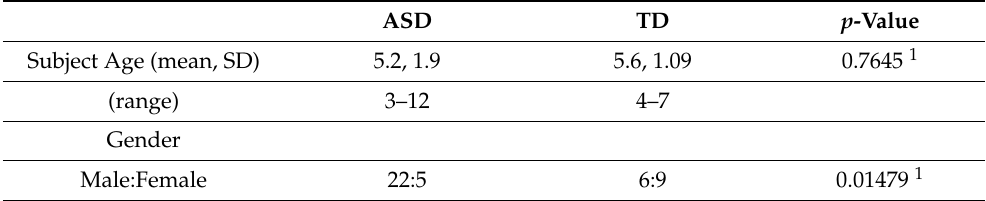
Table 1. Age and gender characteristics of ASD and TD groups.